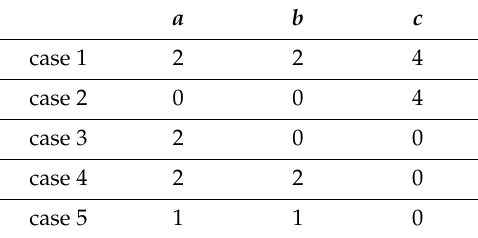
Table 2. Number of different honeypot locations.